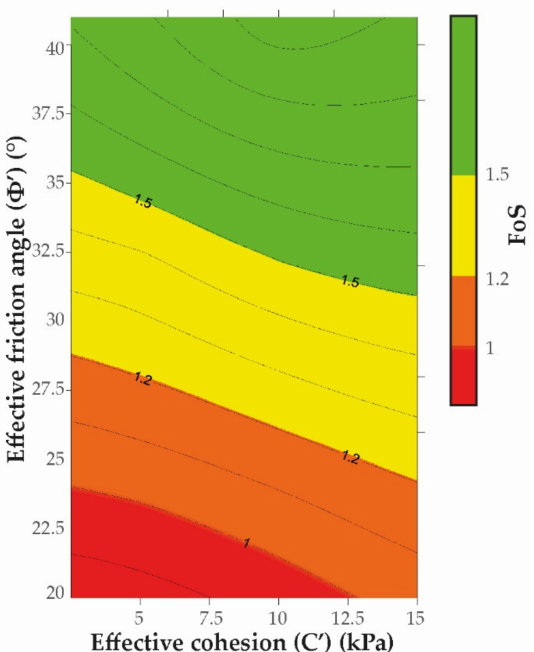
Figure 7. Sensitivity analysis of the intermediate unit. Slope instability along the topographic profile is obtained only at the toe of the slope under wet conditions when the C’ effective cohesion and Φ ’ effective friction angle have lower values. FoS: factor of